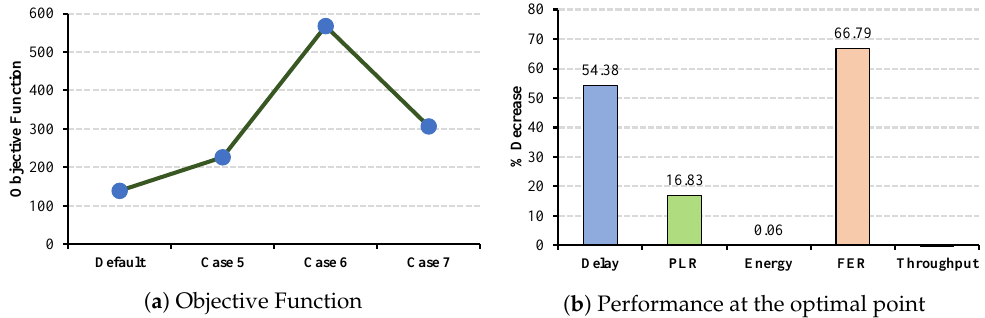
( b ) Performance at the optimal point Figure 19. EMR QoS metrics and energy consumption under CW changes for master